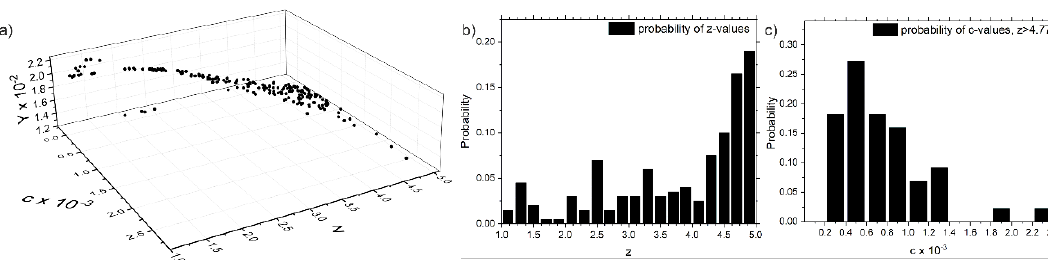
Figure 8. ( a ) Numerically calculated solution space of equation 5.7 for paired values c , z , resulting in the least Error Y , ( b ) 20-bin histogram of z -values and ( c ) histogram of c -values for z lying within the most probable bin ( z >